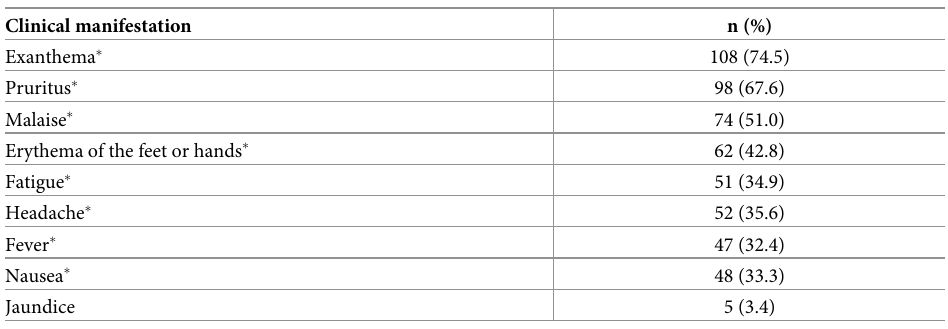
Table 2. Systemic manifestations observed at hospital admission.